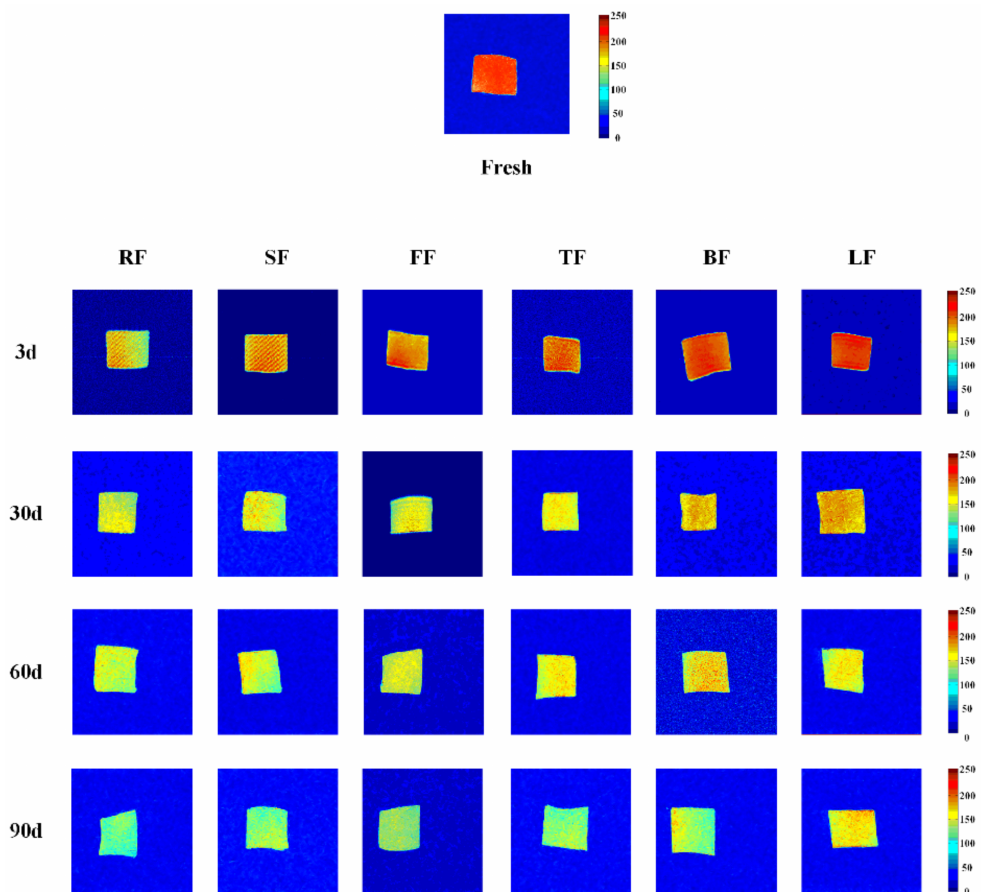
Figure 4. Magnetic resonance imaging (MRI) of cuttlefish by different freezing methods during frozen storage at − 18 ◦